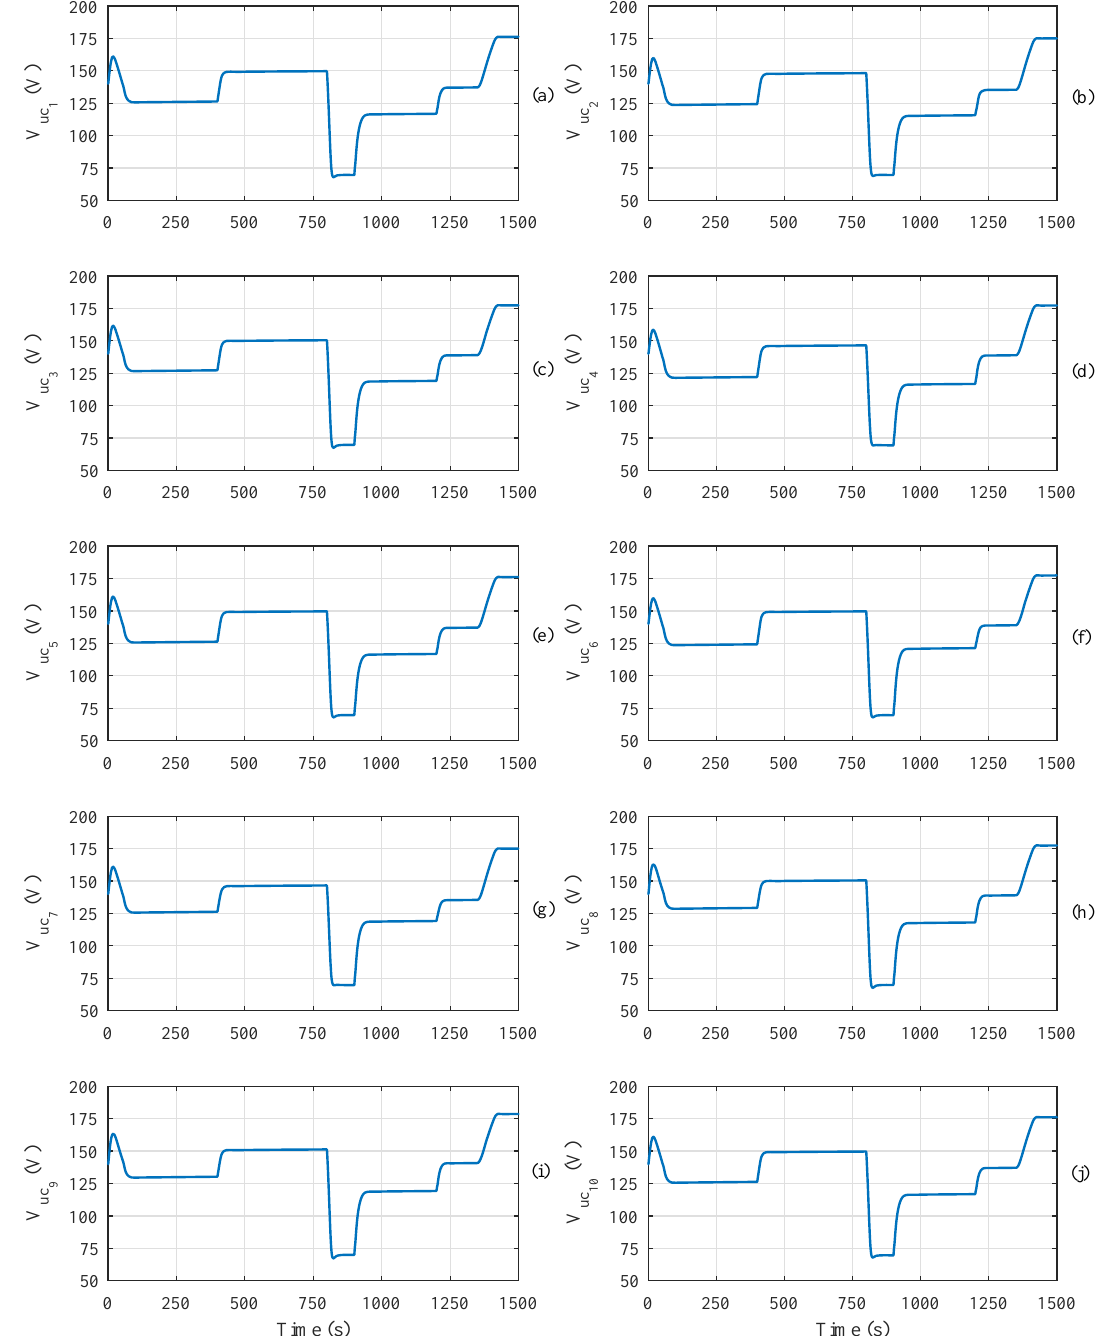
Figure 20. Voltages of the ultracapacitors of the 10 hybrid energy storage systems (HESSs). ( a ) v uc ( b ) v uc ; ( c ) v uc ; ( d ) v uc ; ( e ) v uc ; ( f ) v uc ; ( g ) v uc ; ( h ) v uc ; ( i ) v uc ; and ( j ) v uc 2 3 5 6 7 8 9 4